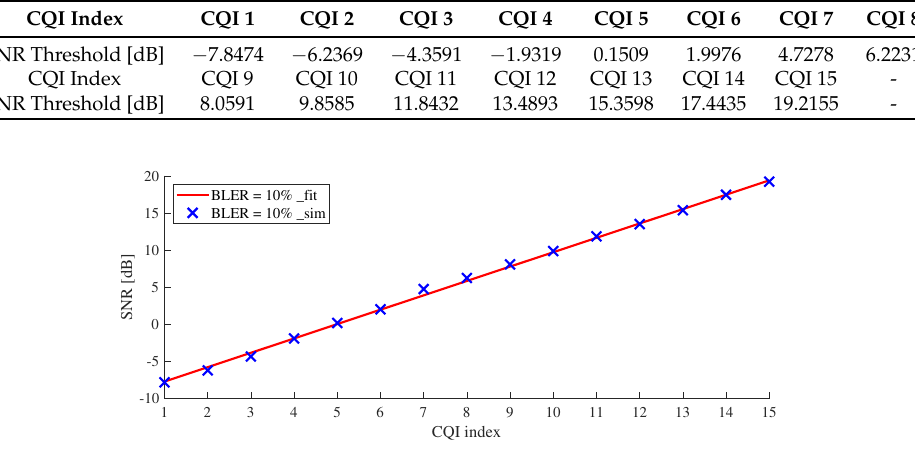
Figure 6. SNR threshold for all CQIs under 5G